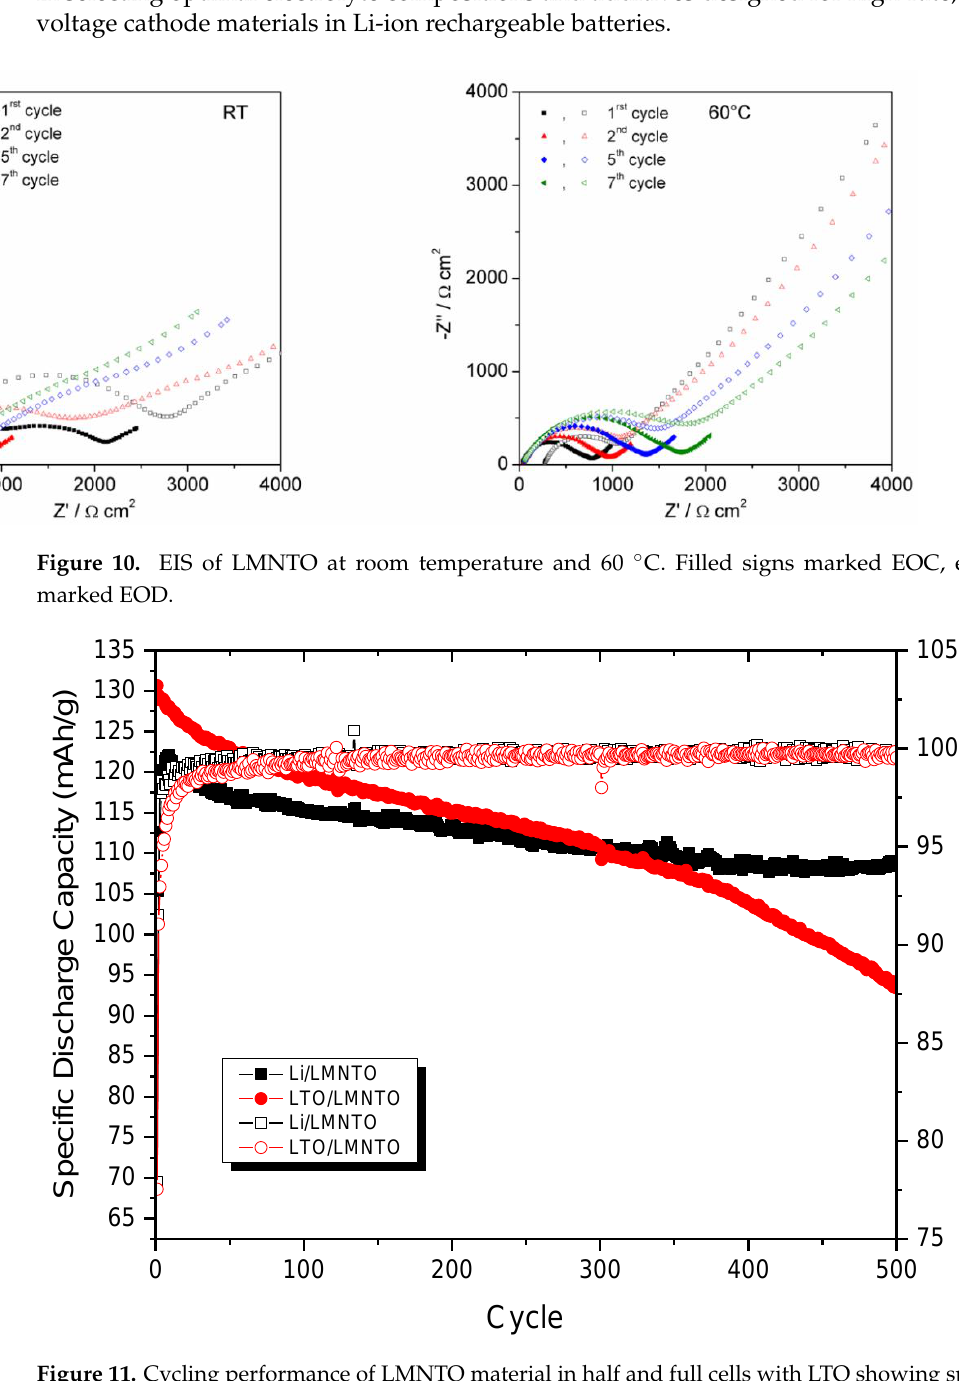
Figure 11. Cycling performance of LMNTO material in half and full cells with LTO showing specific discharge capacity for 500 cycles.